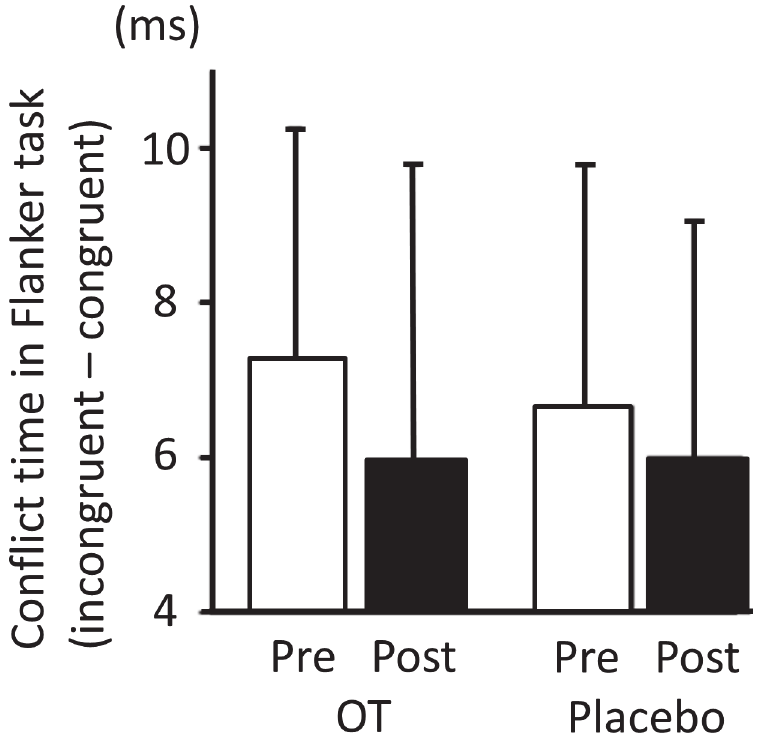
Fig 4. Conflict duration on the flanker task (i.e., reaction time for each incongruent trial – reaction time for each congruent trial) pre- (white bar) and post-treatment (black bar) with OT or placebo. Two-way ANOVA (treatment × drug) failed to demonstrate any drug or treatment effects, and no significant interaction between these two factors was detected. Therefore, we failed to demonstrate any OT-related effect on attentional-inhibitory control. The error bars represent 1 standard